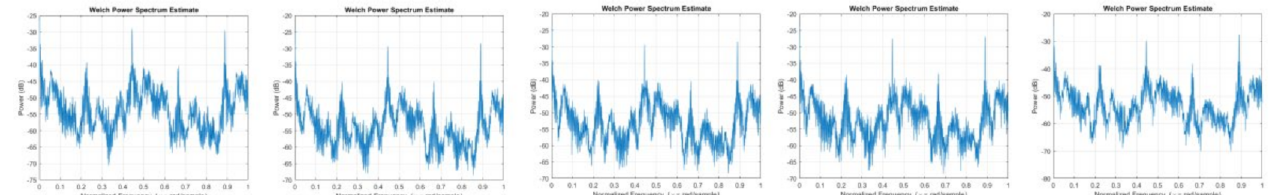
Figure 6. Power Spectral Feature Computation for STPS Gait